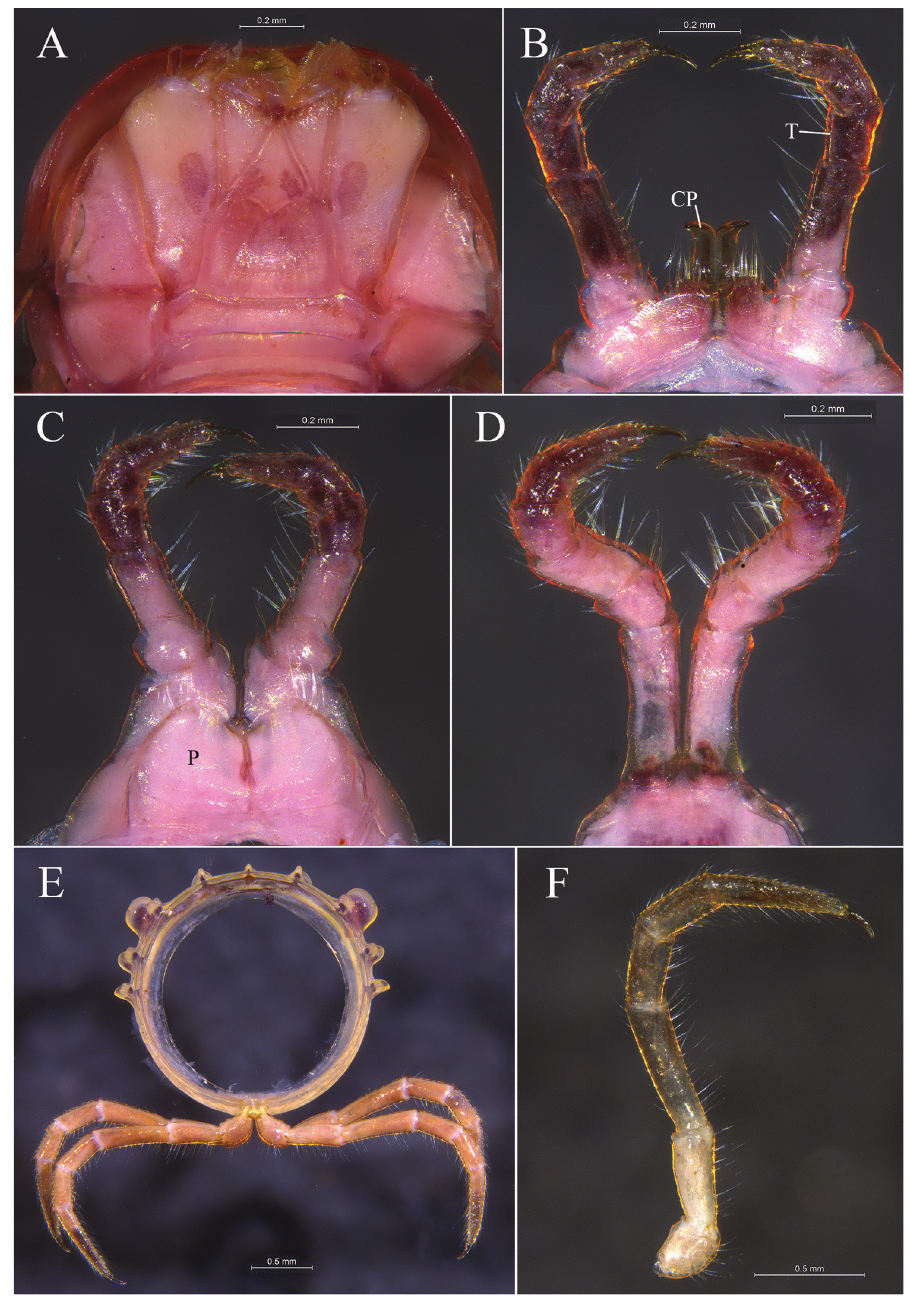
Figure 13. Glyphiulus guangnanensis sp. n., holotype. A gnathochilarium, ventral view B legs I, anterior view C legs II, caudal view D legs III, caudal view E cross-section of a midbody segment, caudal view F midbody leg, anterior view. Abbreviations: CP = coxal process; P = penes; T =